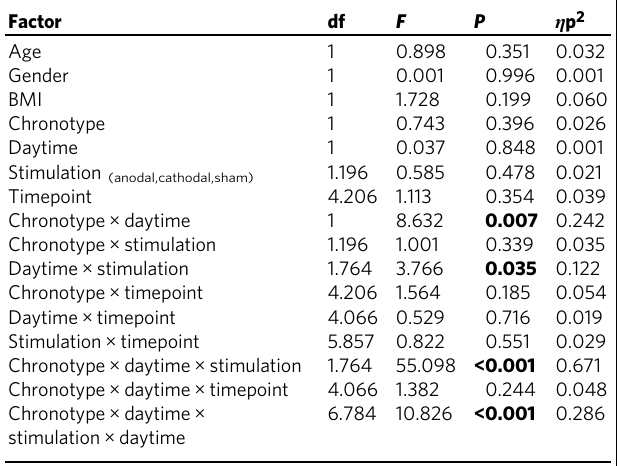
Table 2 The results of mixed-factorial ANOVA for the effect of tDCS on MEP amplitudes in early and late